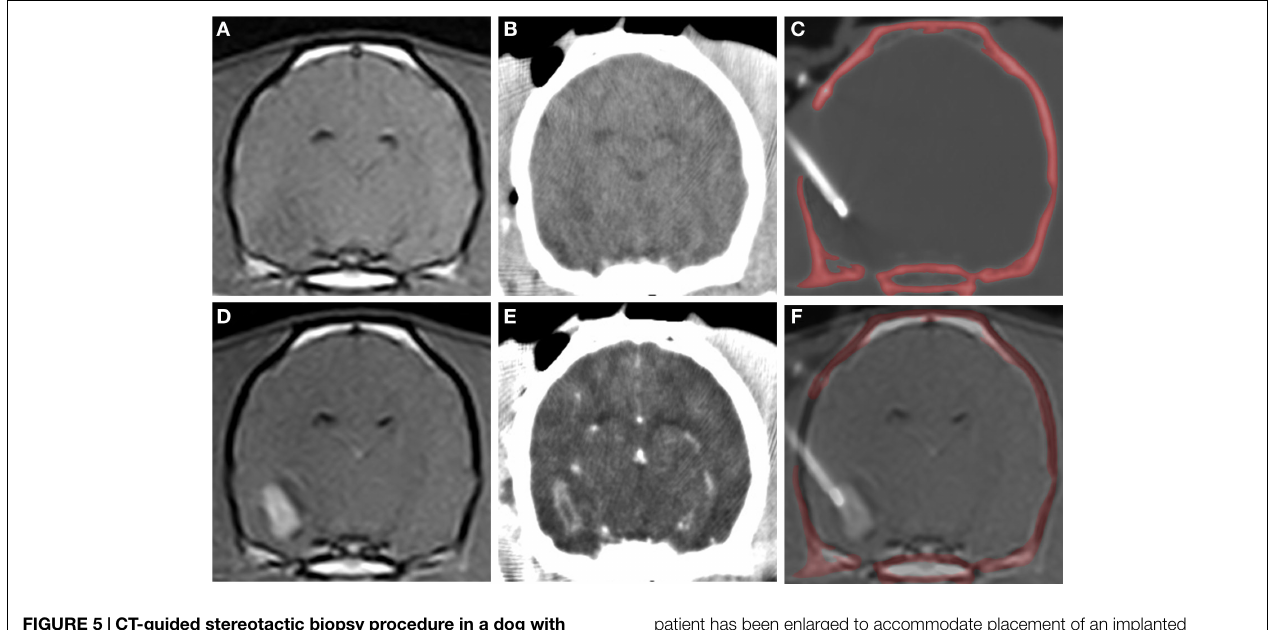
FIGURE 5 | CT-guided stereotactic biopsy procedure in a dog with a Grade III oligodendroglioma . Transverse, pre-contrast (A,B) and post-contrast (C,D) T1-weighted MR (A,D) with corresponding stereotactic CT planning images (B,E) . Intraoperative transverse CT image (C) with biopsy needle in situ . The craniectomy defect in this